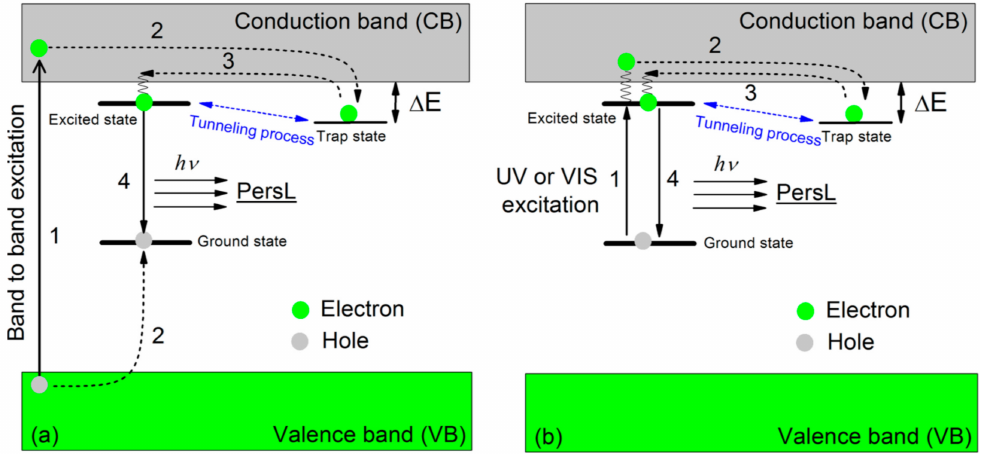
Figure 2. Schematic illustration showing the proposed mechanisms of PersL in inorganic phosphors (electron trapping-detrapping model): ( a ) Band-to-band excitation by high energy light; ( b ) UV or visible light excitation. Reproduced from Ref. [5] with permission. Copyright 2018,